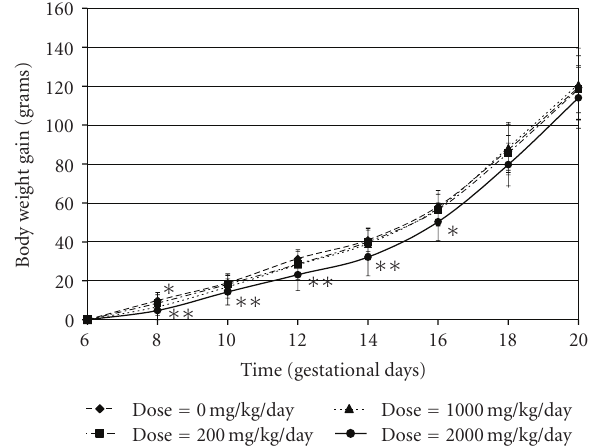
Figure 2: Changes in body weight gain (grams) observed in dams exposed to SE5-OH during gestational days 0–20 during the developmental toxicity study in rats; significant when compared to control: ∗ P < . 05; ∗∗ P < .